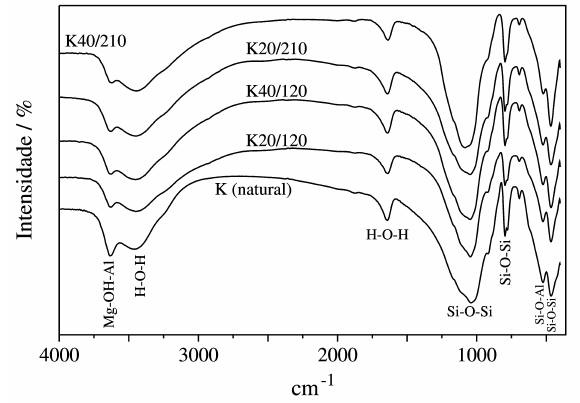
Figura 3. Espectros de IR das amostras natural e ativadas. Tabela 4. Eficiência das bentonitas no descoramento do óleo de soja.